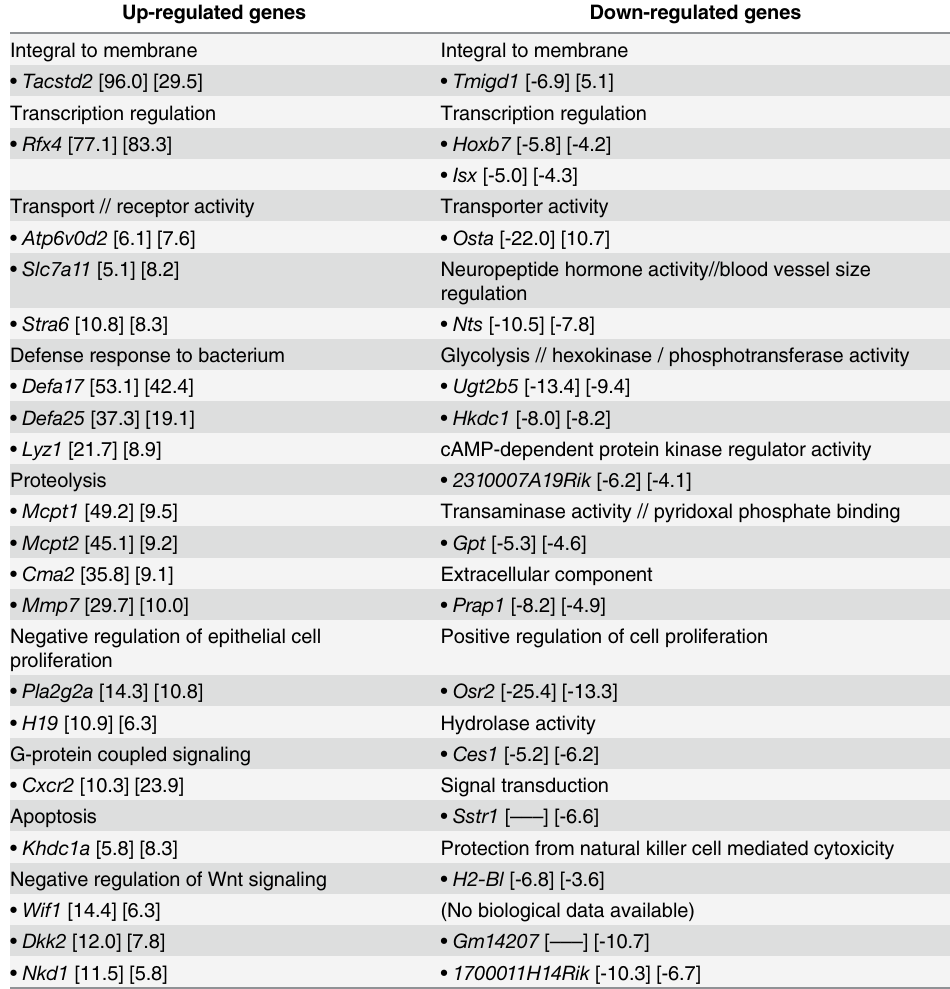
Table 1. The highly deregulated genes, up-regulated (left column) and down-regulated (right column), in the TSP-1 deficient mice after AOM-DSS treatment are categorized according to molecular func- tion/ontology, below. Numbers in brackets represent fold-change: first value refers to fold-change in the comparison between treated TSP-1 -/- vs water-TSP-1 -/- ; second value refers to fold-change com- paring treated TSP-1 -/- vs treated WT, p <